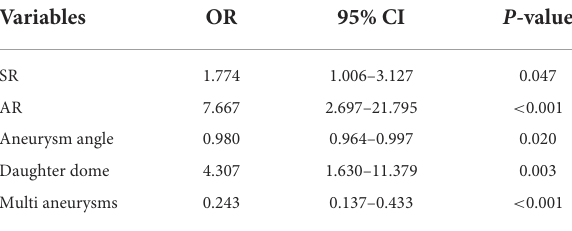
TABLE 2 The multivariate analysis of morphological features of small middle cerebral artery aneurysms in the training cohort.